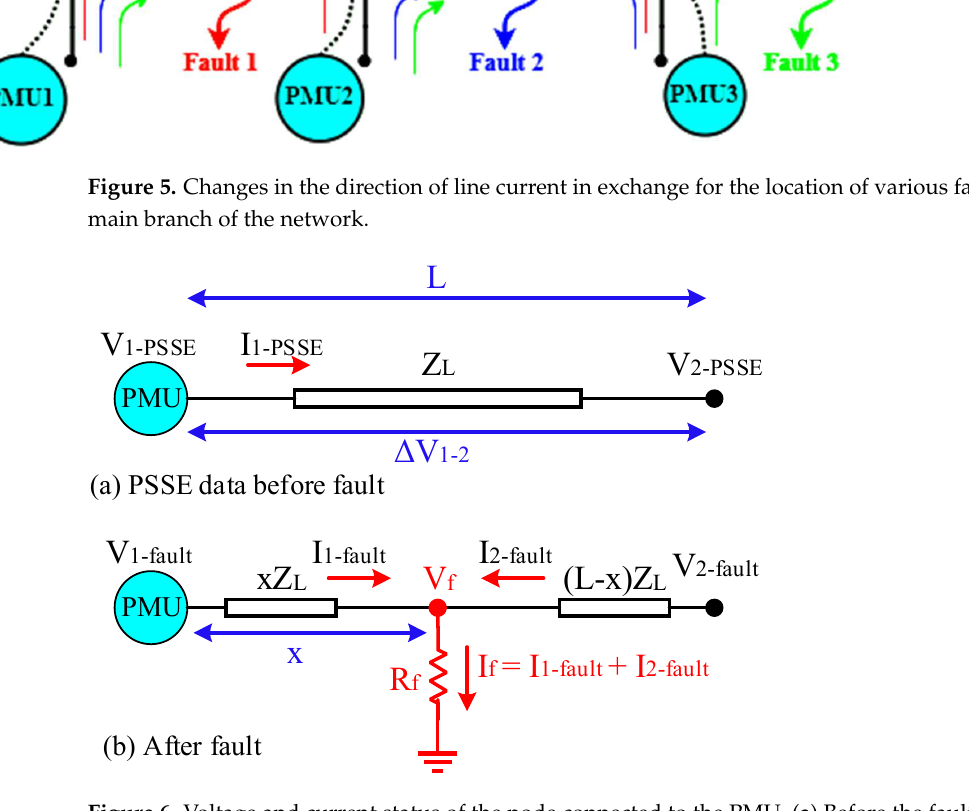
Figure 6. Voltage and current status of the node connected to the PMU. ( a ) Before the fault, ( b ) After the